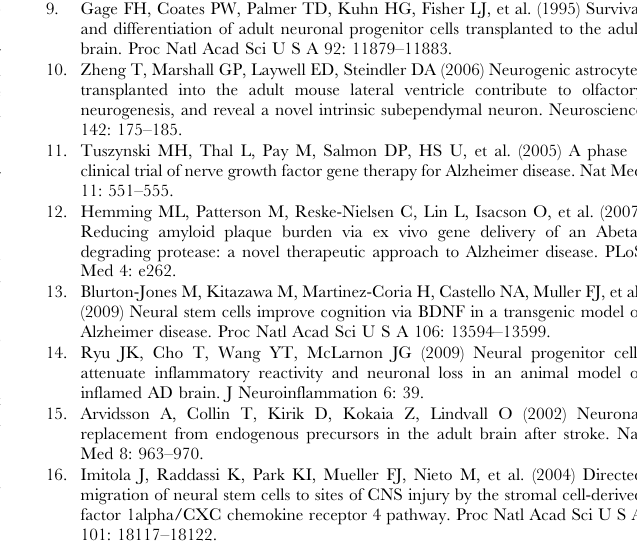
Figure S6 Engraftment in white matter results in permanent localization of NSCs in white matter. We infused NSCs into the fimbria, a white matter structure along the medial edge of the hippocampus. NSCs infused into the fimbria are positioned to migrate into the hippocampus, the thalamus or enter the lateral ventricle. Non-transgenic mice were used to avoid the possibility of effects specific only to AD pathology. Observation of NSCs shortly after infusion ( , 15 min) revealed graft cores of cells in close association of each other within the fimbria (A, n= 6). On the other hand, cells that were engrafted for one year migrated within the fimbria to the walls of the lateral ventricle and near CA3 (B–C, n= 3). No cells were found in the hippocampus or the thalamus (C, arrowheads indicate migrating cells, dashes mark hippocampal border). Thus in our models, NSCs migrated within white matter but did not exit to surrounding